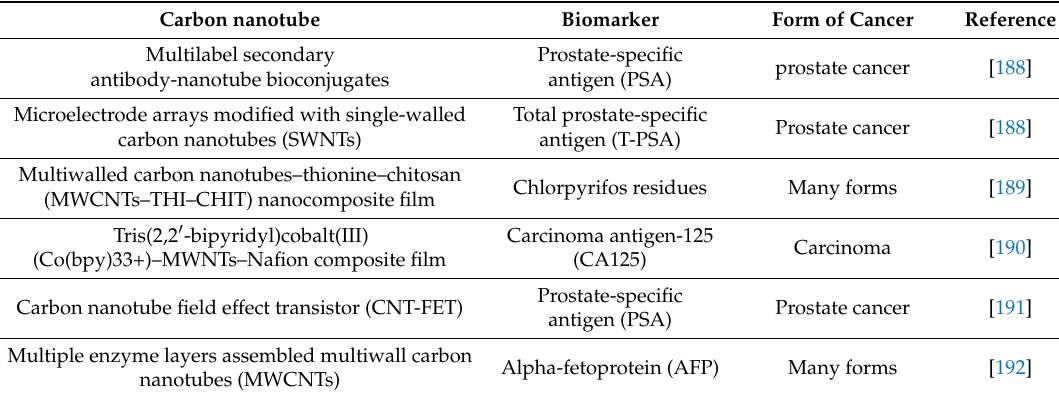
Table 5. Examples of detection of cancer biomarkers by